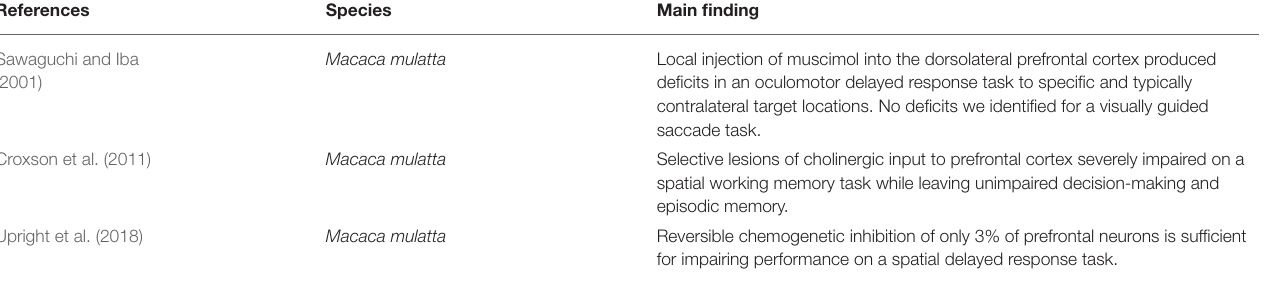
the contents of working memory. The temporal structure of such changes may be variable in individual neurons and across